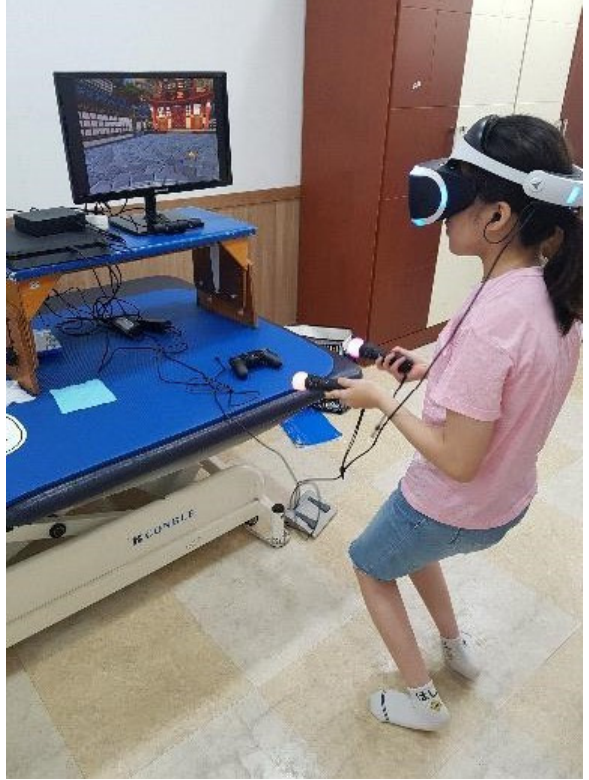
Figure 1. Fully immersive VR game-based training.